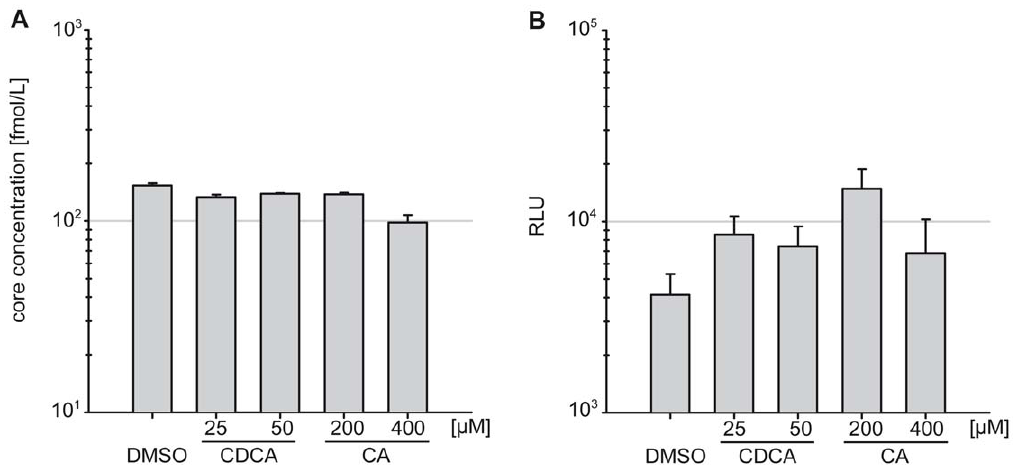
Figure 3. Influence of BAs on HCV particle production and infectivity. Cells were transfected, seeded and treated as described in Fig. 2. Release of core protein as a measure of viral particles in the culture fluid was determined by a commercial core-specific ELISA ( A ). Infectivity of release particles was assessed by inoculation of naı ¨ ve Lunet G-luc cells ( B ). Mean values of duplicates and the standard deviation are shown.